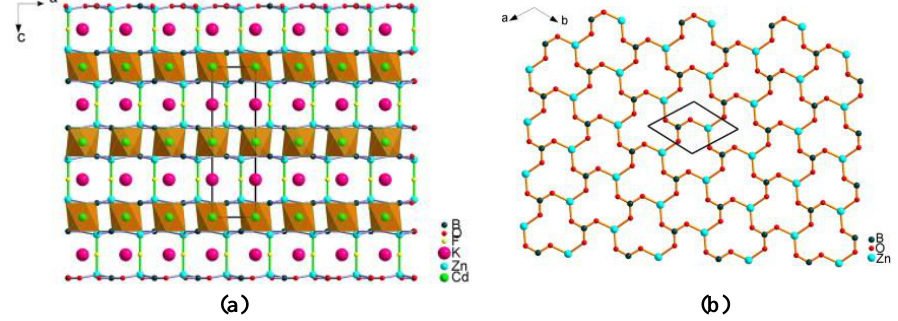
Figure 5. ( a ) The crystal structure of CdZn 2 KB 2 O 6 F viewed along the b -axis; ( b ) the single 2 ∞ [ZnBO 3 ] layer. Reprinted from Ref. [99], Copyright (2009) with permission from Elsevier.